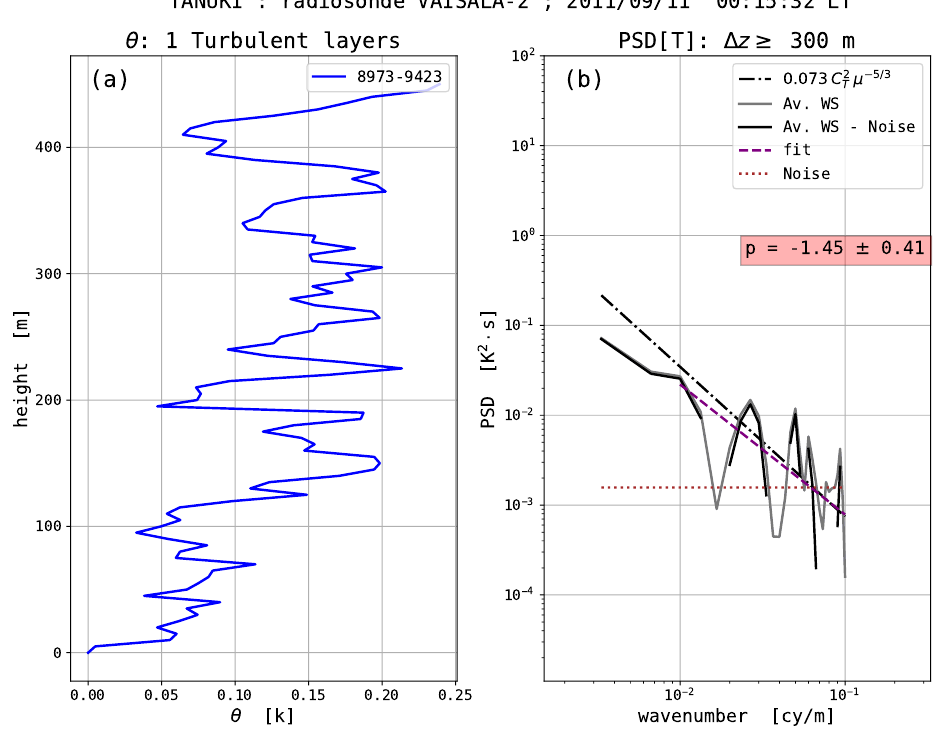
Figure 6. ( a ) Potential Temperature (PT) profile of an unstable layer for flight T11-2. The PTs values are shifted in order to be zero at the bottom of the layer. The vertical axis shows the height of the layer relatively to the bottom height, the altitude range being indicated as the legend of the curve. ( b ) The gray curve shows the power spectrum, the black curve shows the "corrected" power spectrum obtained by subtracting the noise level. The dotted line is the estimated noise level by assuming a white noise. The dot-dashed line shows the shape and level of the Obukhov-Corrsin (OC) spectrum. The dashed line shows the linear fit for the domain of scales 10–100 m; the slope ± standard deviation is indicated in the colored